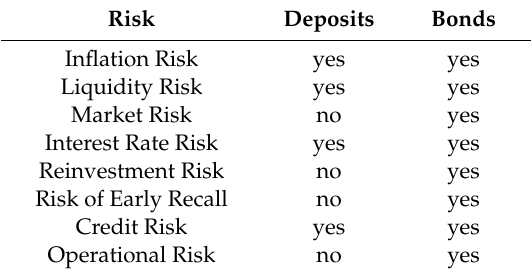
Table 3. Investment Risks in Bonds and Deposits in the Russian Federation